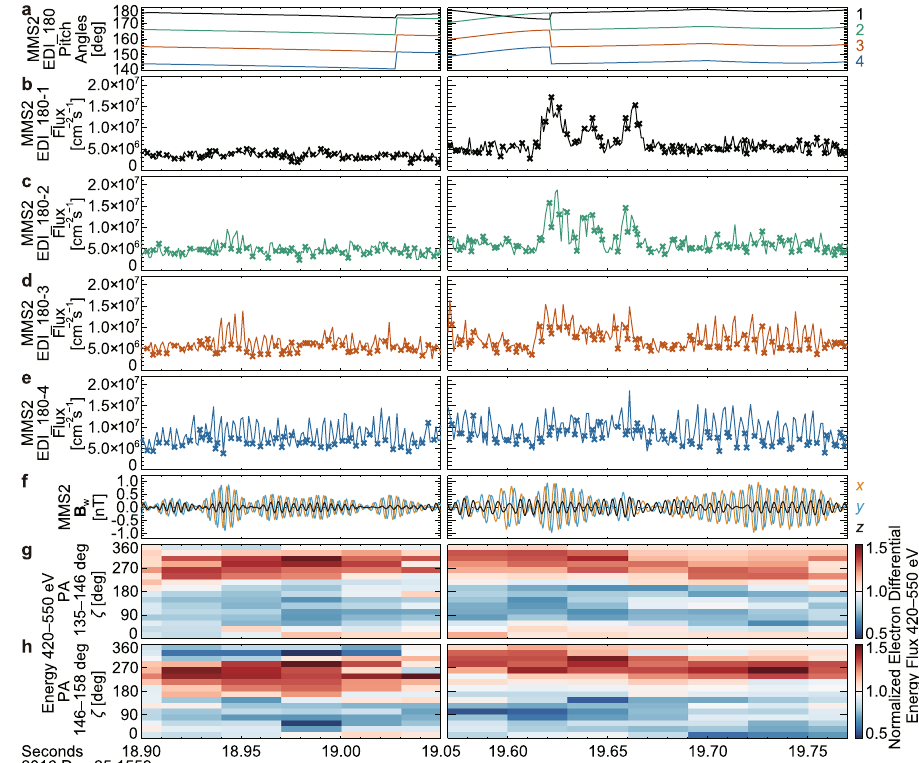
Fig. 5 | Modulation of electron fl ux (Event 1). a Pitch angle (PA) variation of looking directions of each channel of the electron drift instruments that observe the side anti-parallel to B 0 (EDI_180). b – e Electron fl ux (500eV) measured by 4 channels of EDI_180. The data points measured within 60° from ζ =90 (cid:3) are high- lighted with crosses. f Waveform of the magnetic fi eld ( B w ) in the fi eld aligned coordinate (FAC). g , h ζ - t spectra of normalized differential energy fl uxes of